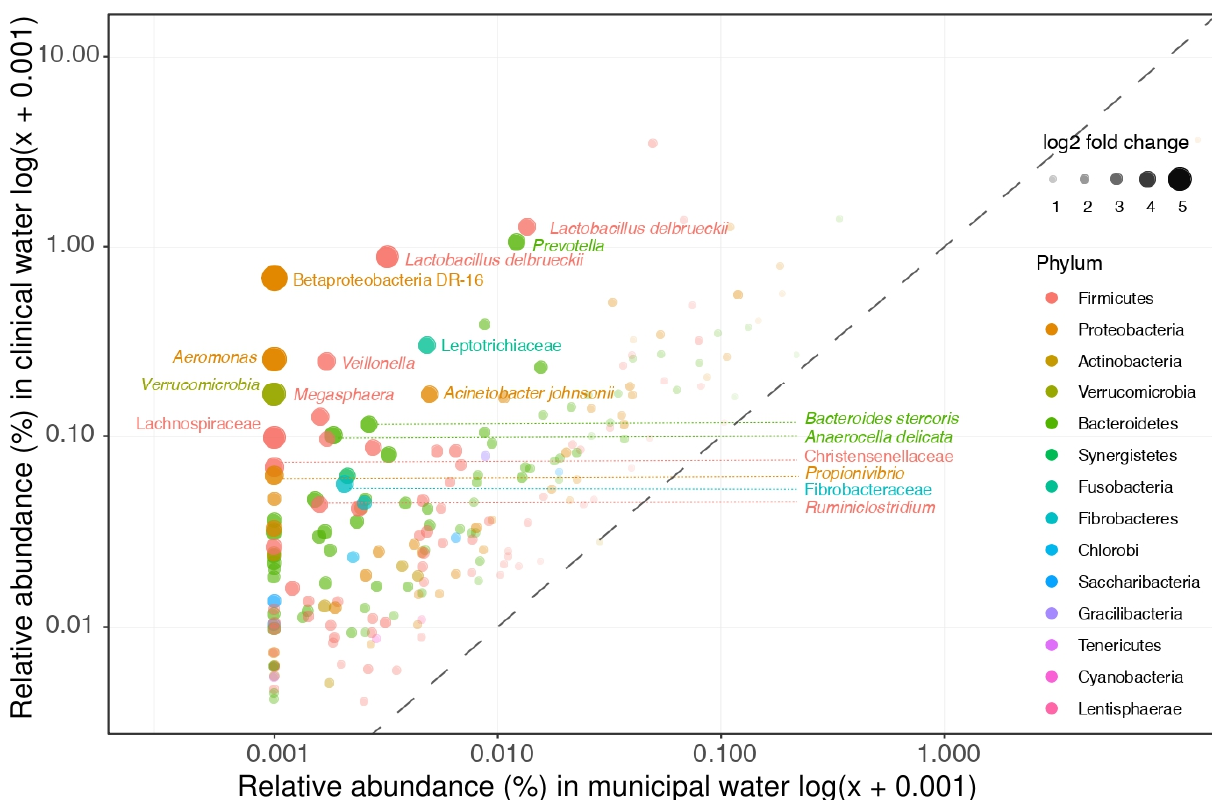
Figure 2. Clinical enriched taxa. Clinical enriched taxa were defined as taxa that were significantly more abundant in both hospital and nursing home wastewater as compared to municipal wastewater. The relative abundances of these taxa in hospital and municipal wastewaters are depicted. The clinical most enriched taxa are not members of our selected target taxa (i.e., Lactobacillus delbrueckii and Prevotella